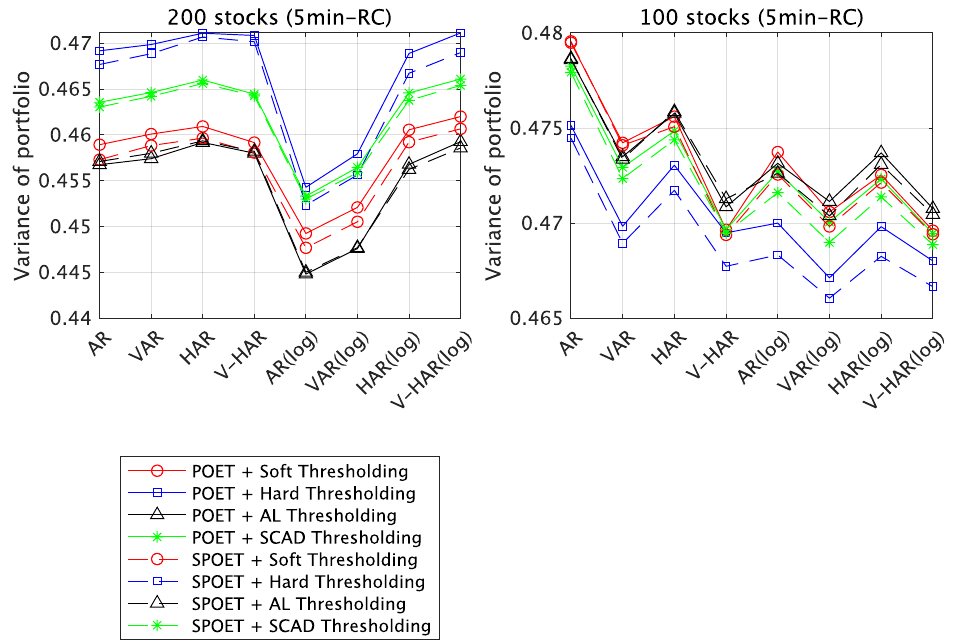
Figure 4. The variance of portfolios estimated by each model using 5-min interval intraday